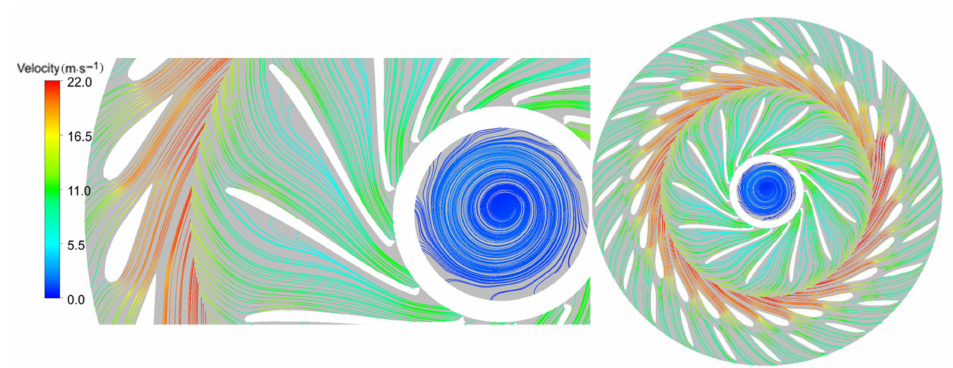
Figure 8. Flow pattern of vaneless space at 15 degrees of opening.